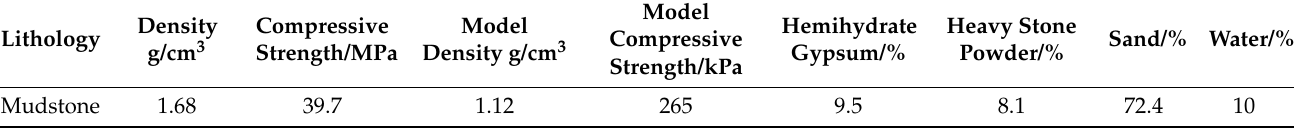
Table 1. Material proportioning plan for sample